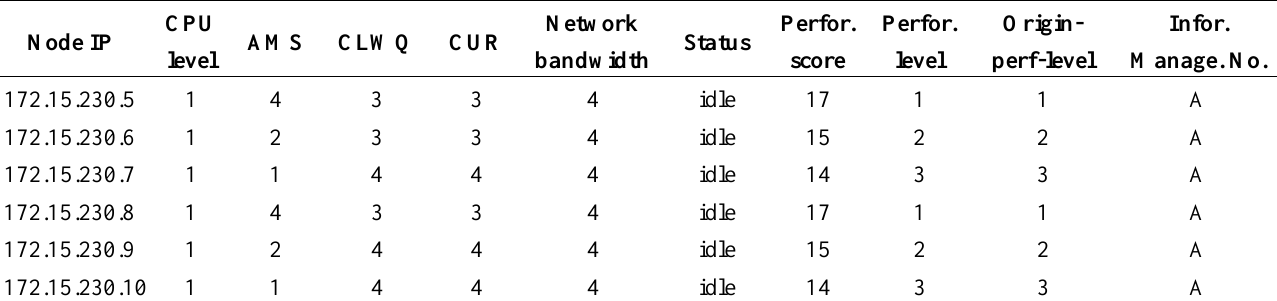
Table 10. The initial performance